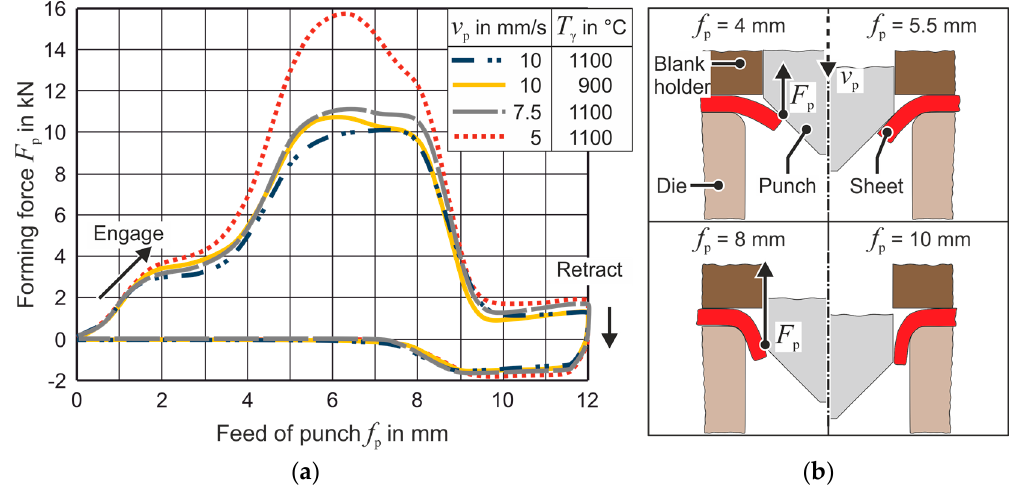
Figure 5. ( a ) Force acting on the punch F p during engaging and retracting at different punch velocities v p and austenitizing temperatures T γ ; ( b ) Schematic contact situation during forming (engaging) between sheet and punch for progressing feed f p .